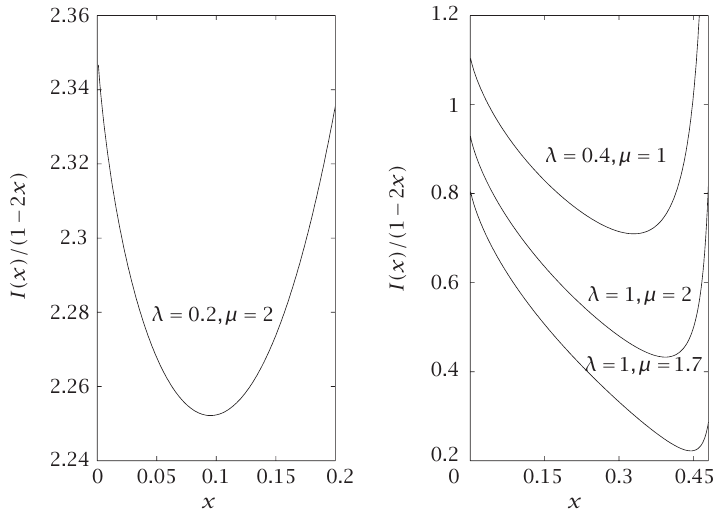
= − 1, 0 )) against x for r 0